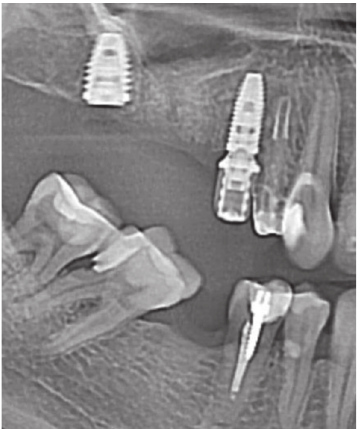
Figure 14: Bone regeneration after 6 weeks.